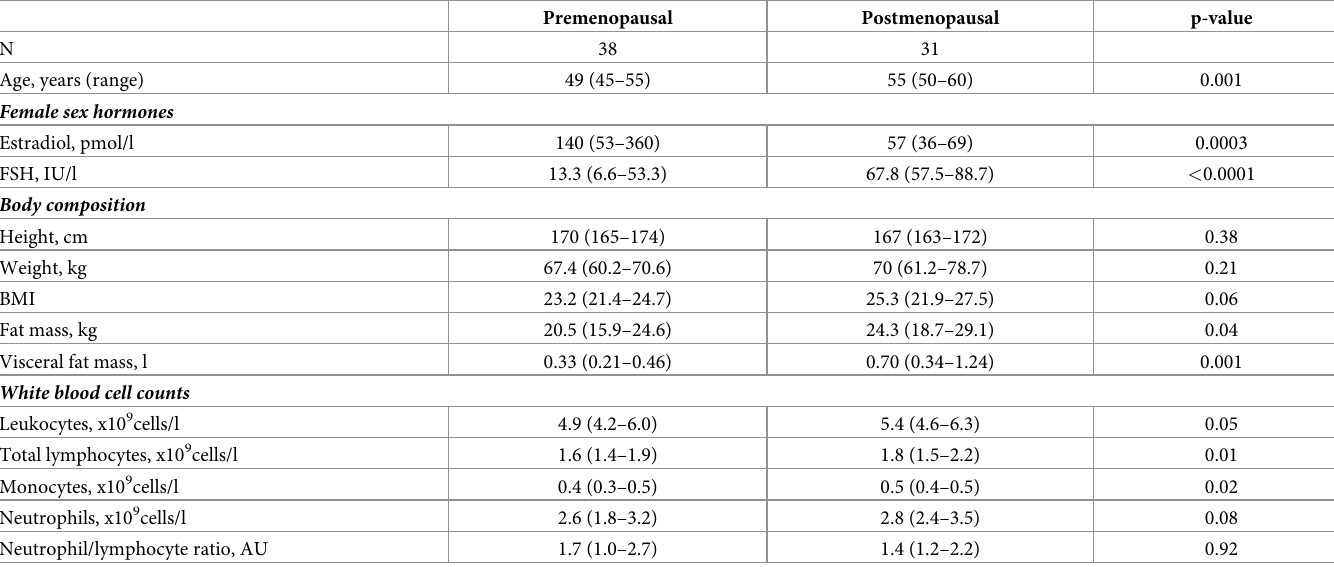
Table 1. Subject characteristics of pre- and postmenopausal women.